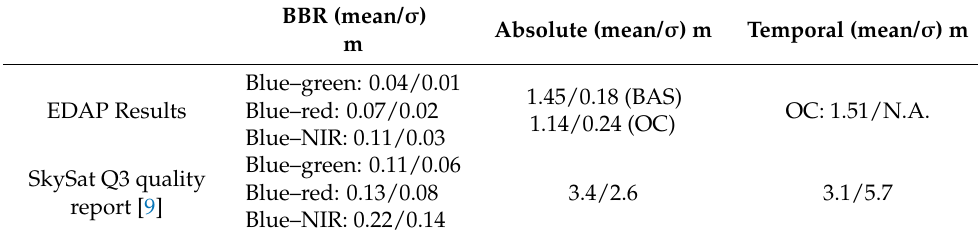
Table 8. SkySat geolocation uncertainty results. All results are in meters. BBR (mean/ σ ) Absolute (mean/ σ ) m Temporal (mean/ σ ) m m Blue–green: 0.04/0.01 1.45/0.18 (BAS) EDAP Results Blue–red: 0.07/0.02 OC: 1.51/N.A. 1.14/0.24 (OC) Blue–NIR: 0.11/0.03 Blue–green: 0.11/0.06 SkySat Q3 quality Blue–red: 0.13/0.08 3.4/2.6 report [9] Blue–NIR: 0.22/0.14